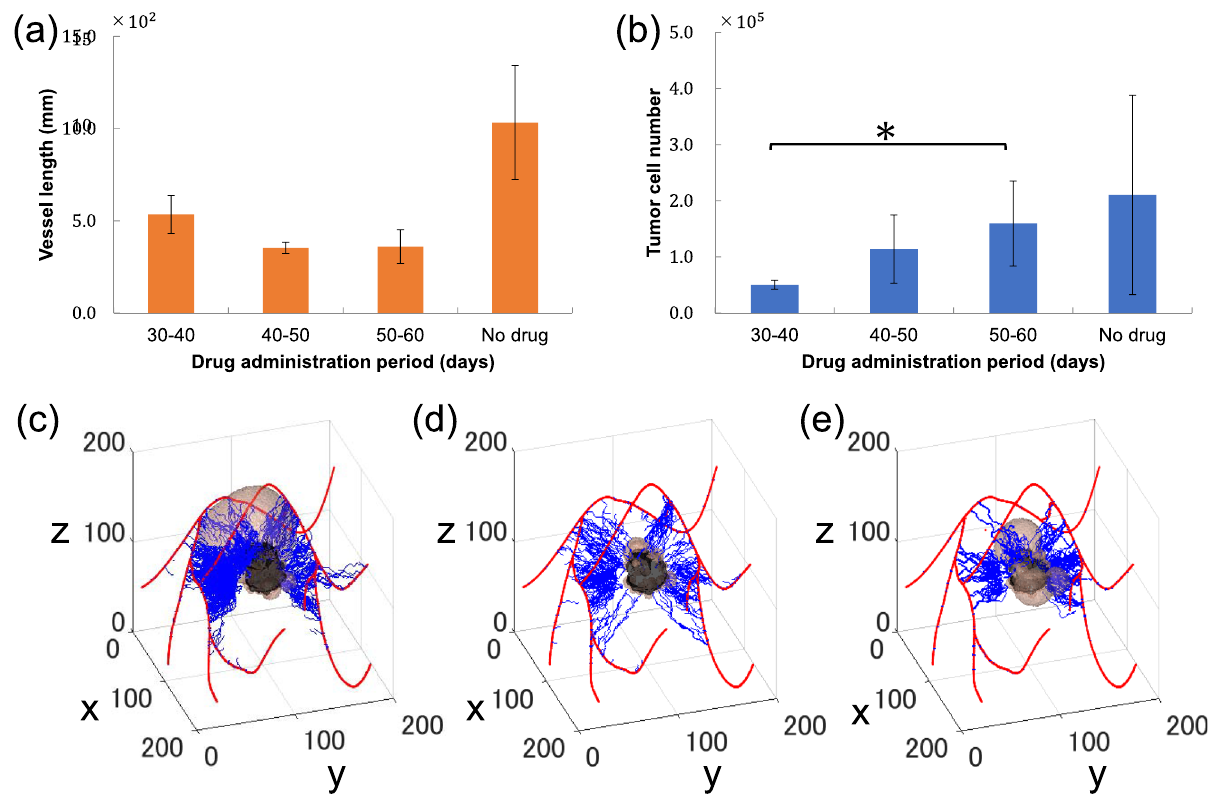
Figure 5. Change in simulation results with timing of administration. ( a , b ) Changes in tumour number and neovascular length on day 60, according to the time of administration: The x-axis represents drug administration conditions, while the y-axes represent the number of tumour cells ( a ) and the length of new vessels ( b ) on day 60. Bars and error bars show the mean and standard deviation, respectively, for each medication condition. * P < 0.05 (Student’s t -test, Bonferroni correction (n = 5)). ( c – e ) Vascular and tumour status on day 60 in the absence of the drug, and with drug administration for 30–40 and 50–60 days: The red curve shows existing blood vessels in the human body, while the blue curve shows newly sprouted central location (Figure S5). As shown in Eq. (22), the probability of capillary sprouting increased with increases in [VEGF]. As Ang2 secretion commenced in the sprouting grid points, Ang2/Ang1 began to increase on day 10, reaching a temporary peak on day 23 (Fig. 4). Late to the increase in Ang2/Ang1, the length of new vessels began to increase on day 15, suggesting that increased [Ang2], compared to [Ang1], was an important condition